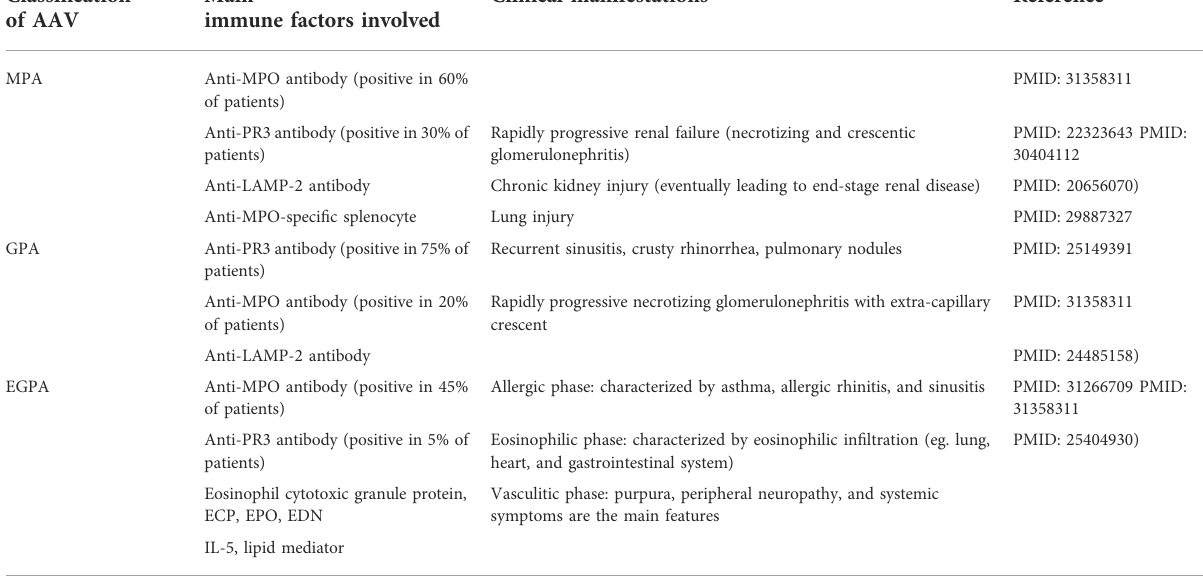
TABLE 2 Main immune factors involved and clinical manifestations of the three major kinds of ANCA-associated vasculitis (AAV). Classi fi cation of